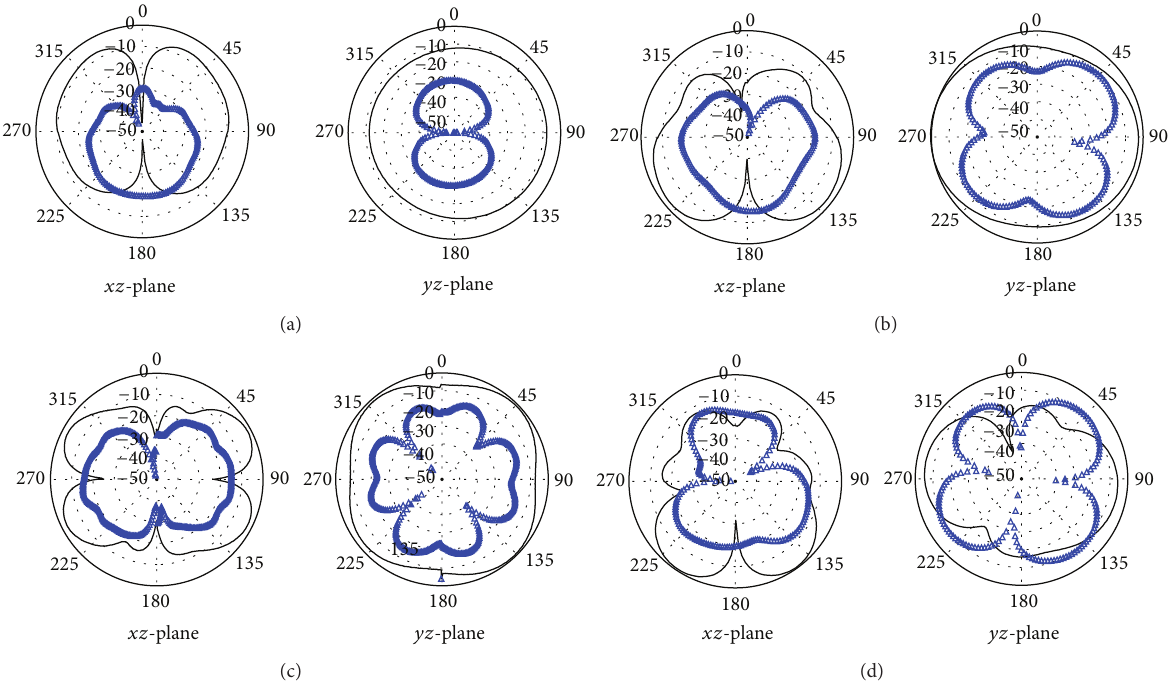
Figure 9: Measured 2D radiation patterns at (a) 3.04 GHz, (b) 6 GHz, (c) 7.38 GHz, and (d) 10 GHz (black solid line: 𝐸 𝜃 ; blue cross line: 𝐸 𝜑 ).